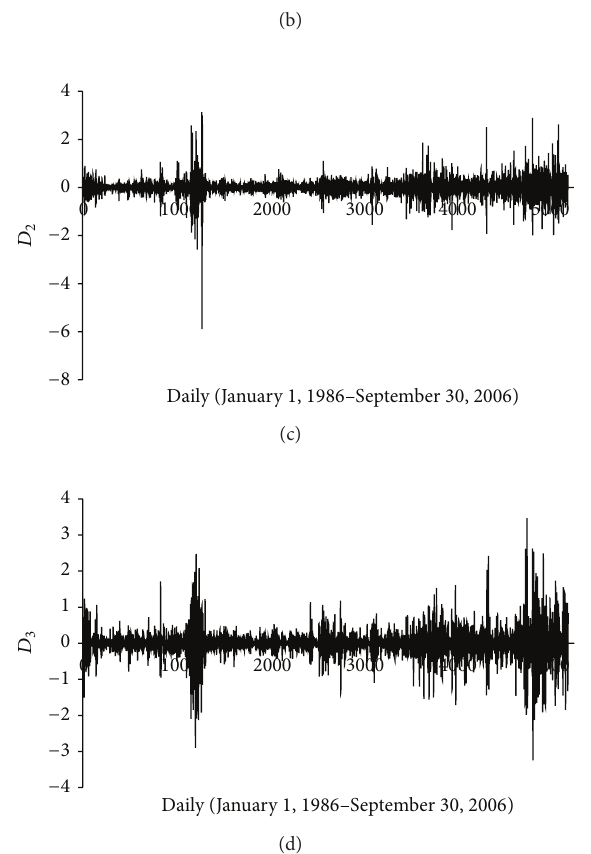
Figure 3: Decomposed wavelet subtime series components (Ds) of WTI crude oil price data.